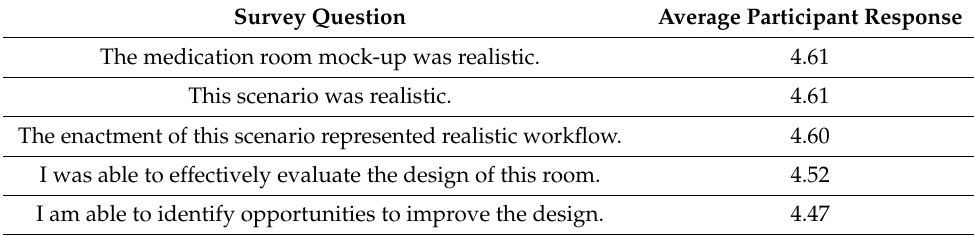
Table 1. Post-scenario enactment survey responses. On a scale of 1 (strongly disagree) to 5 (strongly agree), participants were asked: “Based on this scenario enactment, please rate your level of agree- ment with the following